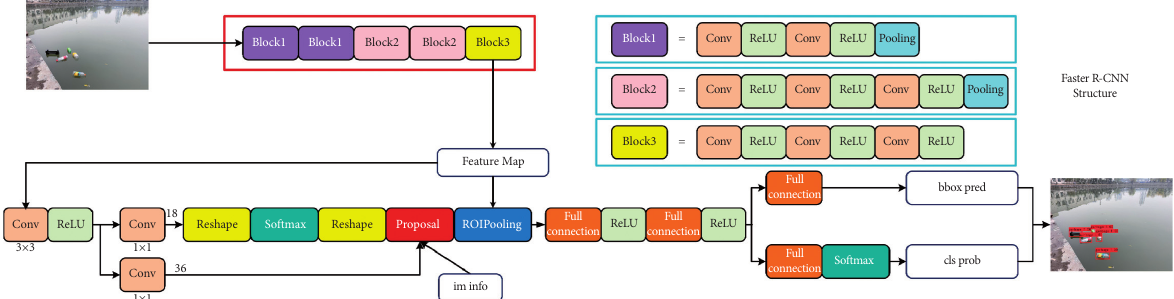
Figure 2: The garbage dataset, which contains 2000 color images in different scales, is developed for deep learning-based automatic detection of water-surface garbage. This current dataset is mainly composed of glass and plastic materials. More types of water-surface garbage will be incorporated into our dataset in the future